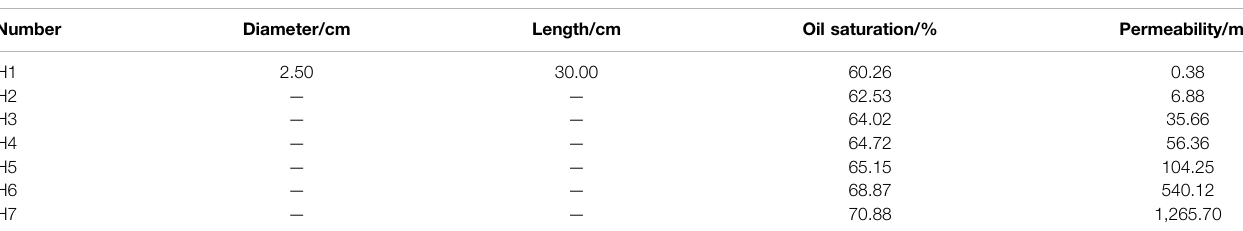
TABLE 2 | Basic parameters of experimental cores.